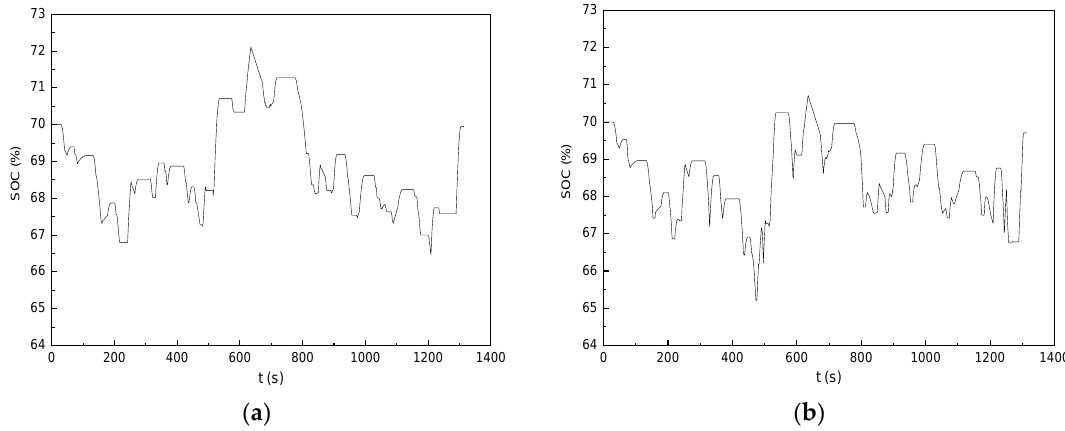
Figure 12. Time histories of battery state of charge (SOC) along the cycle for ( a ) HEV and ( b ) HESV.